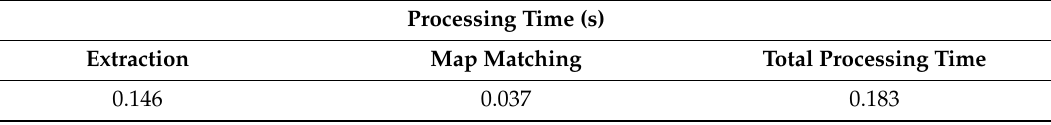
Table 6. Processing time of vehicle localization using the FRPDM.